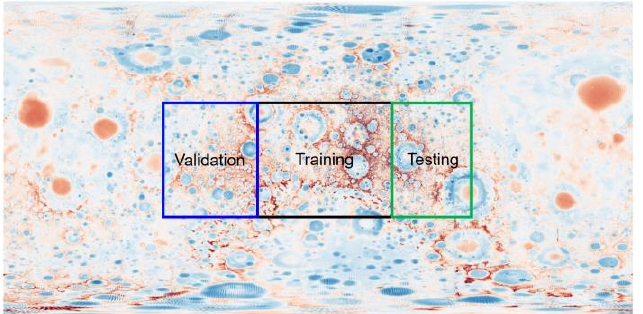
Figure 3. Schematic diagram of data set partition (Black rectangle represents the region of train data sets, blue rectangle represents the region of validation data sets, and green rectangle represents the region of testing data sets). Table 2. The anomaly information of three types of data sets.